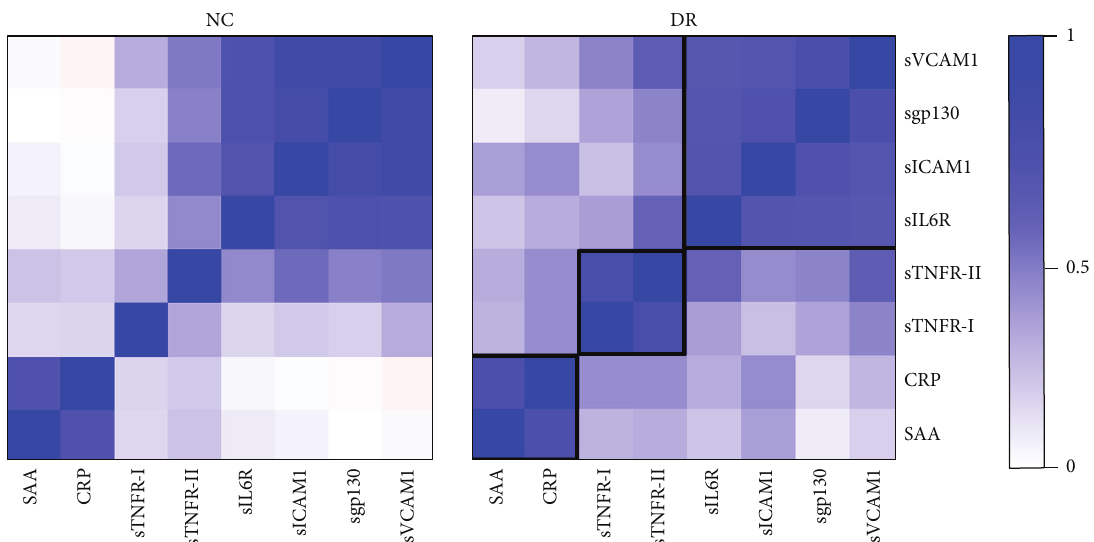
Figure 2: Three clusters of functionally related proteins with strong positive correlations. The pairwise correlations between all eight proteins were examined in T1D patients with and without DR separately. Correlation between individual protein levels was computed using Pearson correlation coefficient. Clustering and visualization of correlation matrix was performed using hierarchical clustering method and heatmap. Three clusters of functionally related proteins were found with strong positive correlations.